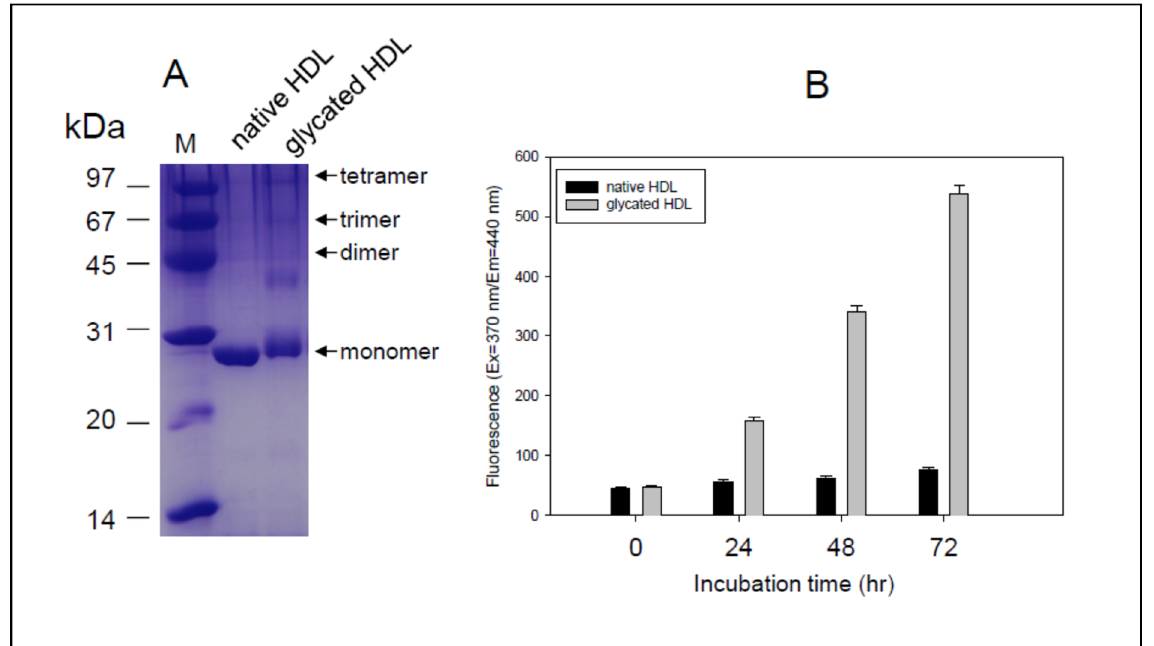
Figure 1. Characterization of HDL. ( A ) Electrophoretic patterns of native HDL and glycated HDL (12% SDS-PAGE). Lane M, molecular weight standard (Bio-Rad, low-range). ( B ) Fluorospectroscopic determination of glycation extent in HDL during 72 hours (hrs).